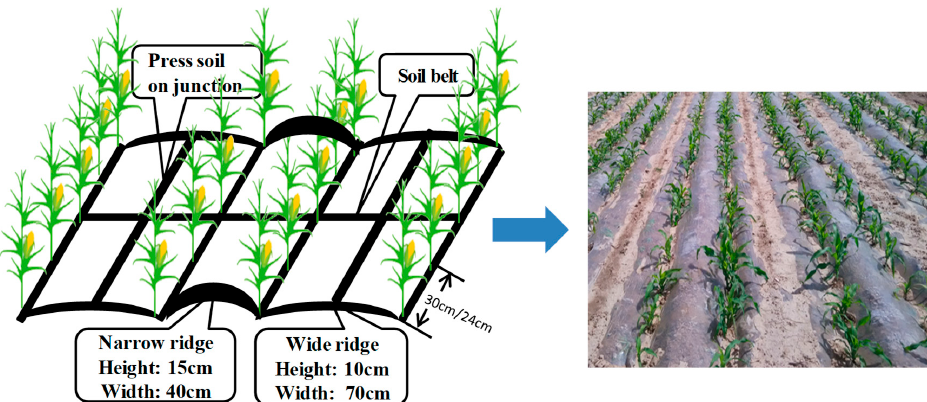
Figure 1. Schematic diagram of PM. Note: The left diagram is a schematic diagram, the right diagram is a field planting diagram, and the middle arrow only indicates that the right diagram is the actual effect of the left diagram.